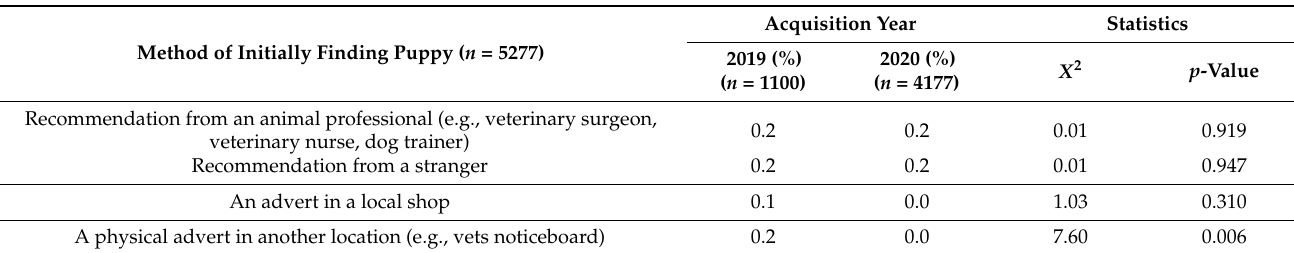
Figure 5. Deposit practices to secure puppies prior to purchase ( n = 4463) with comparison between 2019 owners ( n = 921) and Pandemic Puppy owners ( n = 3452) in the UK.